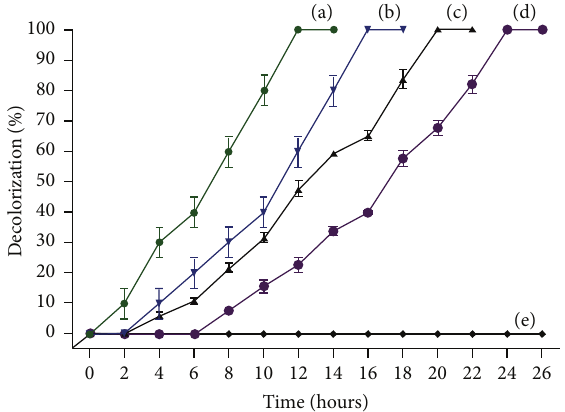
Figure 4: Decolorization of 4-chloro-2-nitrophenol by Bacillus aryabhattai strain PC-7. (a) 0.5 mM 4-chloro-2-nitrophenol, (b) 1.0 mM 4-chloro-2-nitrophenol, (c) 1.5mM 4-chloro-2-nitrophenol, (d) 2.0 mM 4-chloro-2-nitrophenol, and (e) 2.5 mM 4-chloro-2-